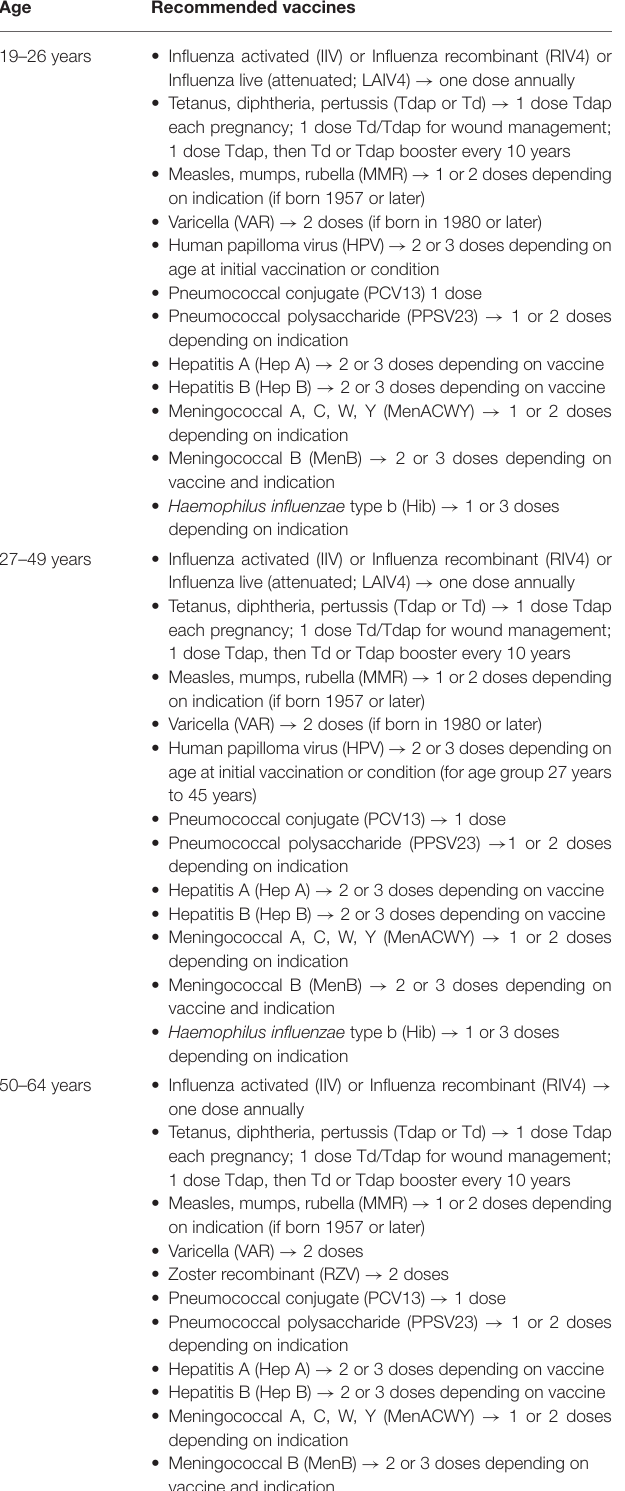
TABLE 3 | CDC recommended adult immunization schedule by age group, United States, 2021. Age Recommended